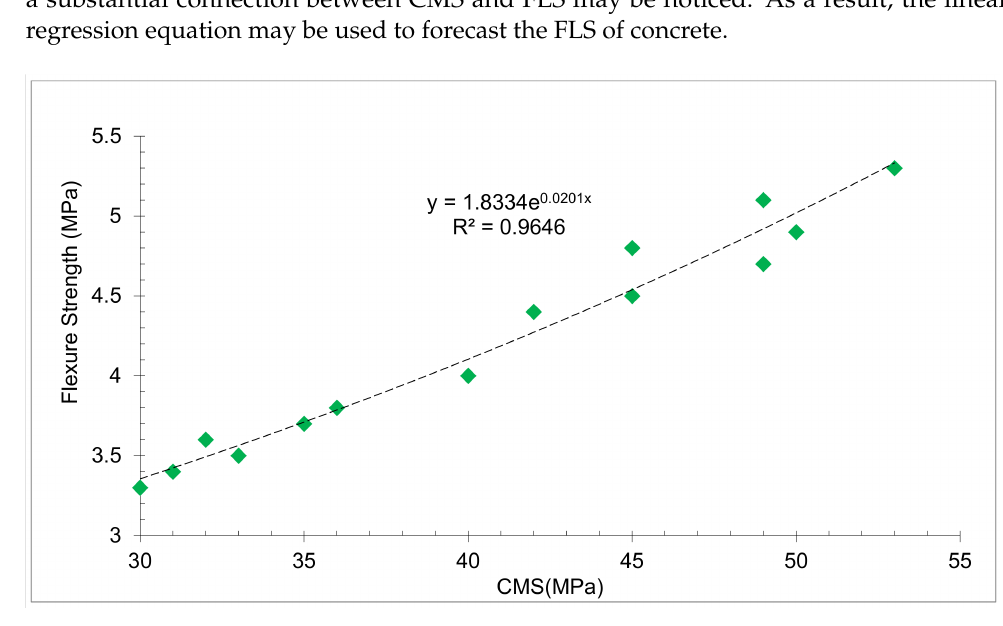
Figure 12. Correlation between Flexural and Compressive Strength: Data Source [44]. Green diamond is the data